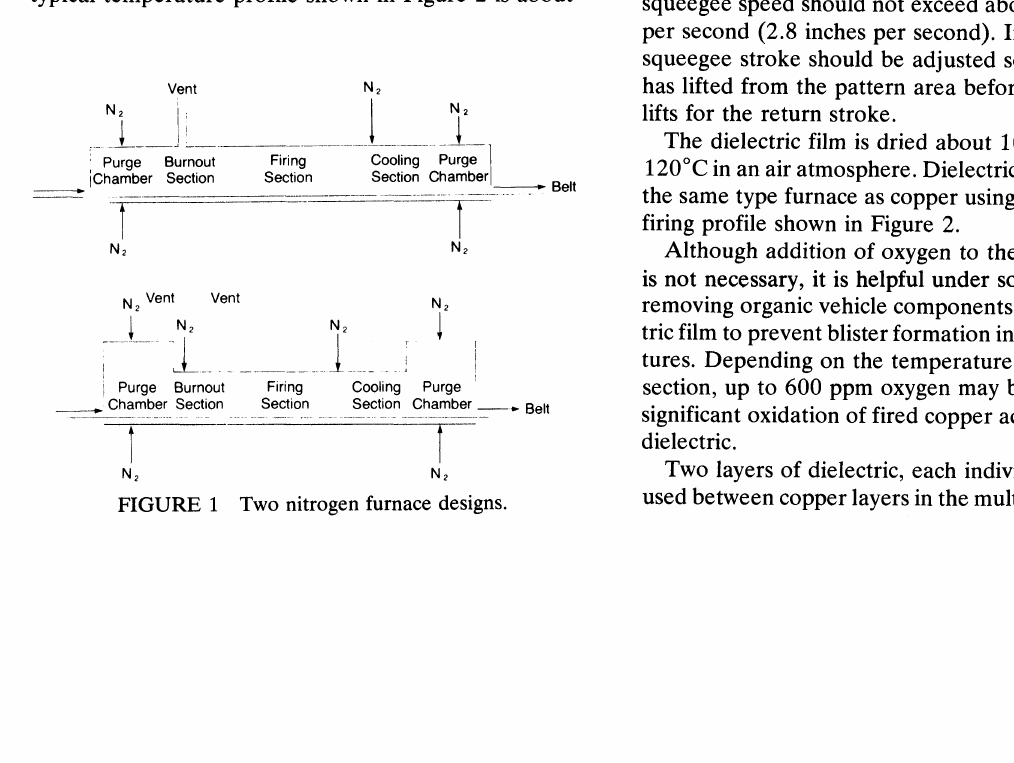
FIGURE 1 Two nitrogen furnace